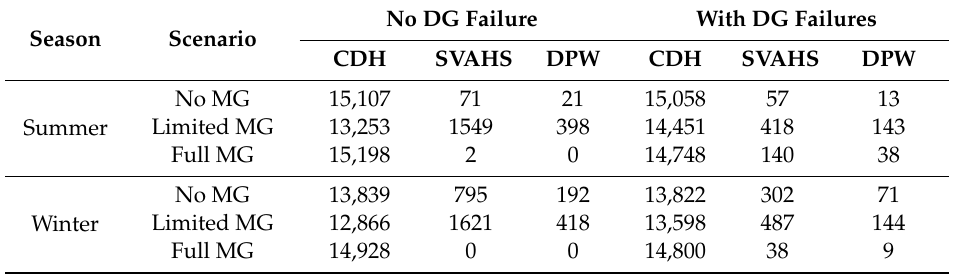
Table 18. Mean diesel fuel consumption (Gallons) of the system without CDH PV in 14 days